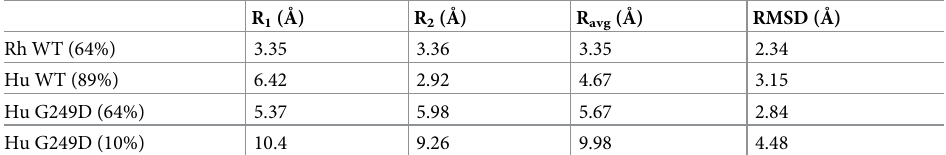
Table 1. Root mean square values for each cluster.